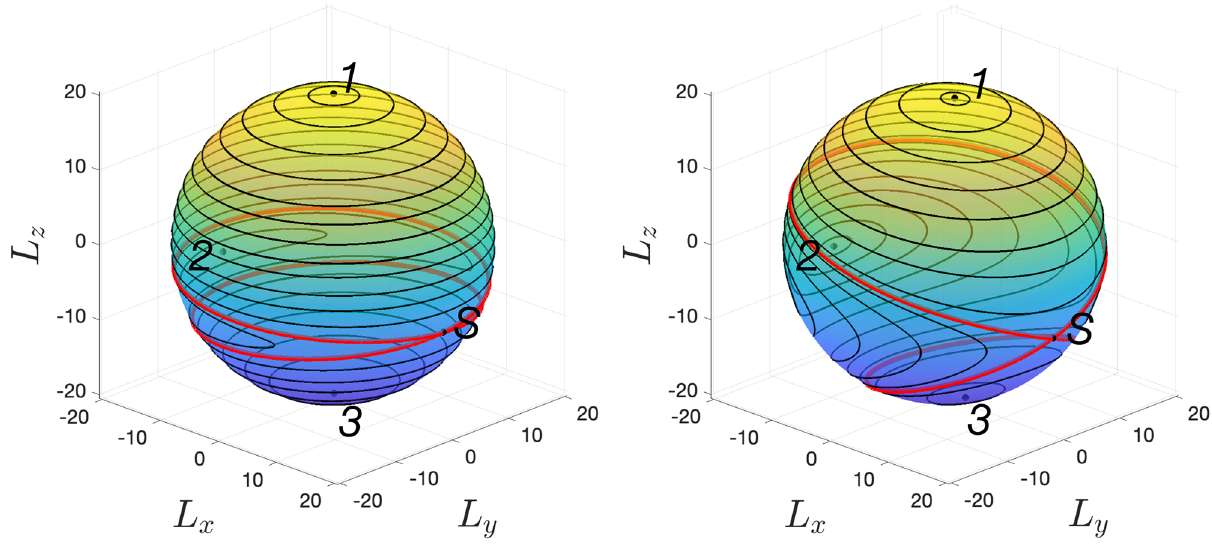
Figure 6. Classical trajectories on the surface of Bloch sphere. Black dots correspond to equilibrium points (three stable—1, 2, 3, and one unstable— S ). The red curve is a Separatrix. Here the parameters are as 0.1211 (left), and g /α 1 40 , α 2 /α 1 27 , g /α 1 0.5 , �/α 1 0.25 , µ follows: N N = ≈ = = = corresponds to the dimensionless coupling strength: √ β